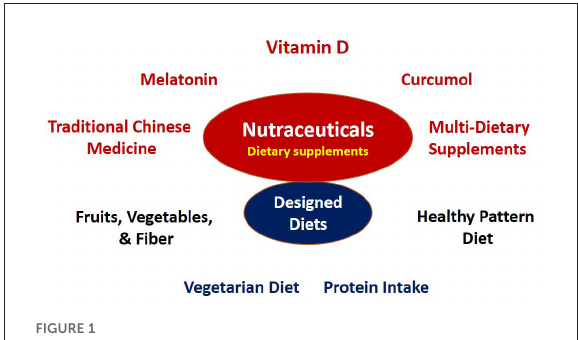
FIGURE1 Nutraceutical supplements and various dietary patterns for the recovery of COVID-19